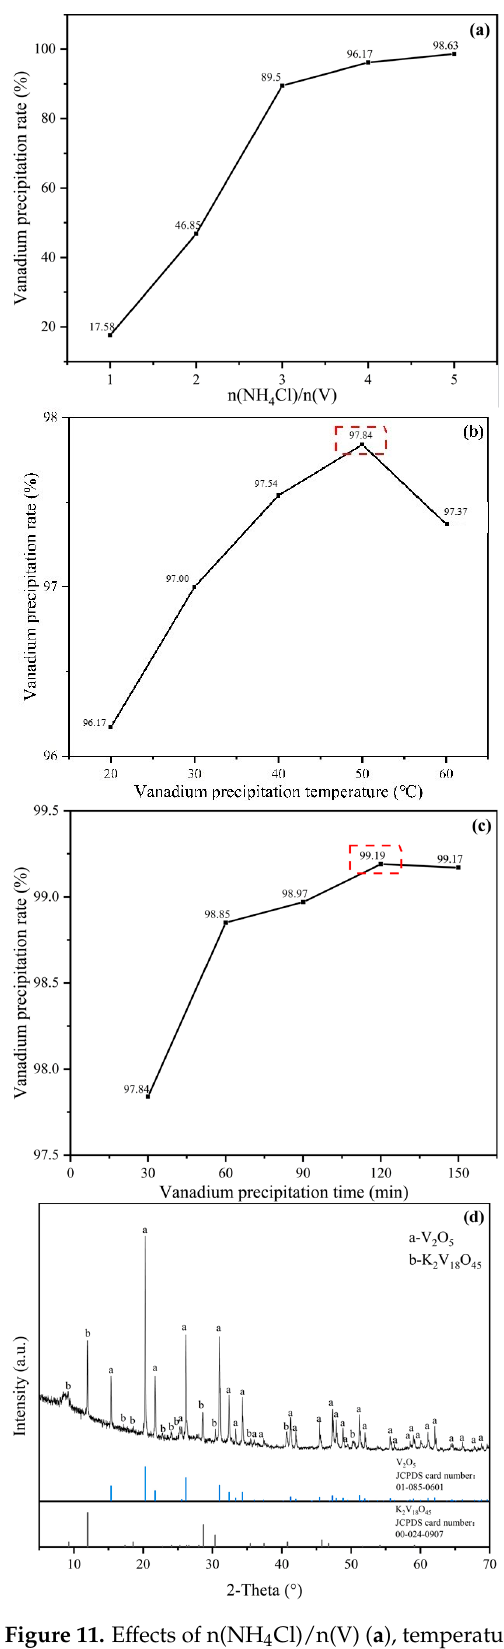
Figure 11. Effects of n(NH 4 Cl)/n(V) ( a ), temperature ( b ), and time ( c ) on the vanadium precipitation rate. XRD patterns of the V 2 O 5 product ( d ).